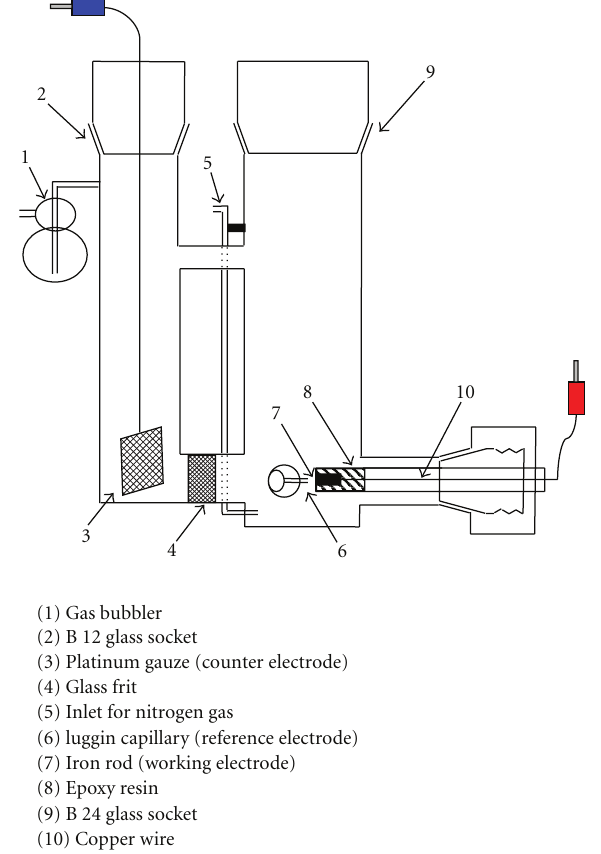
Figure 1: Electrochemical